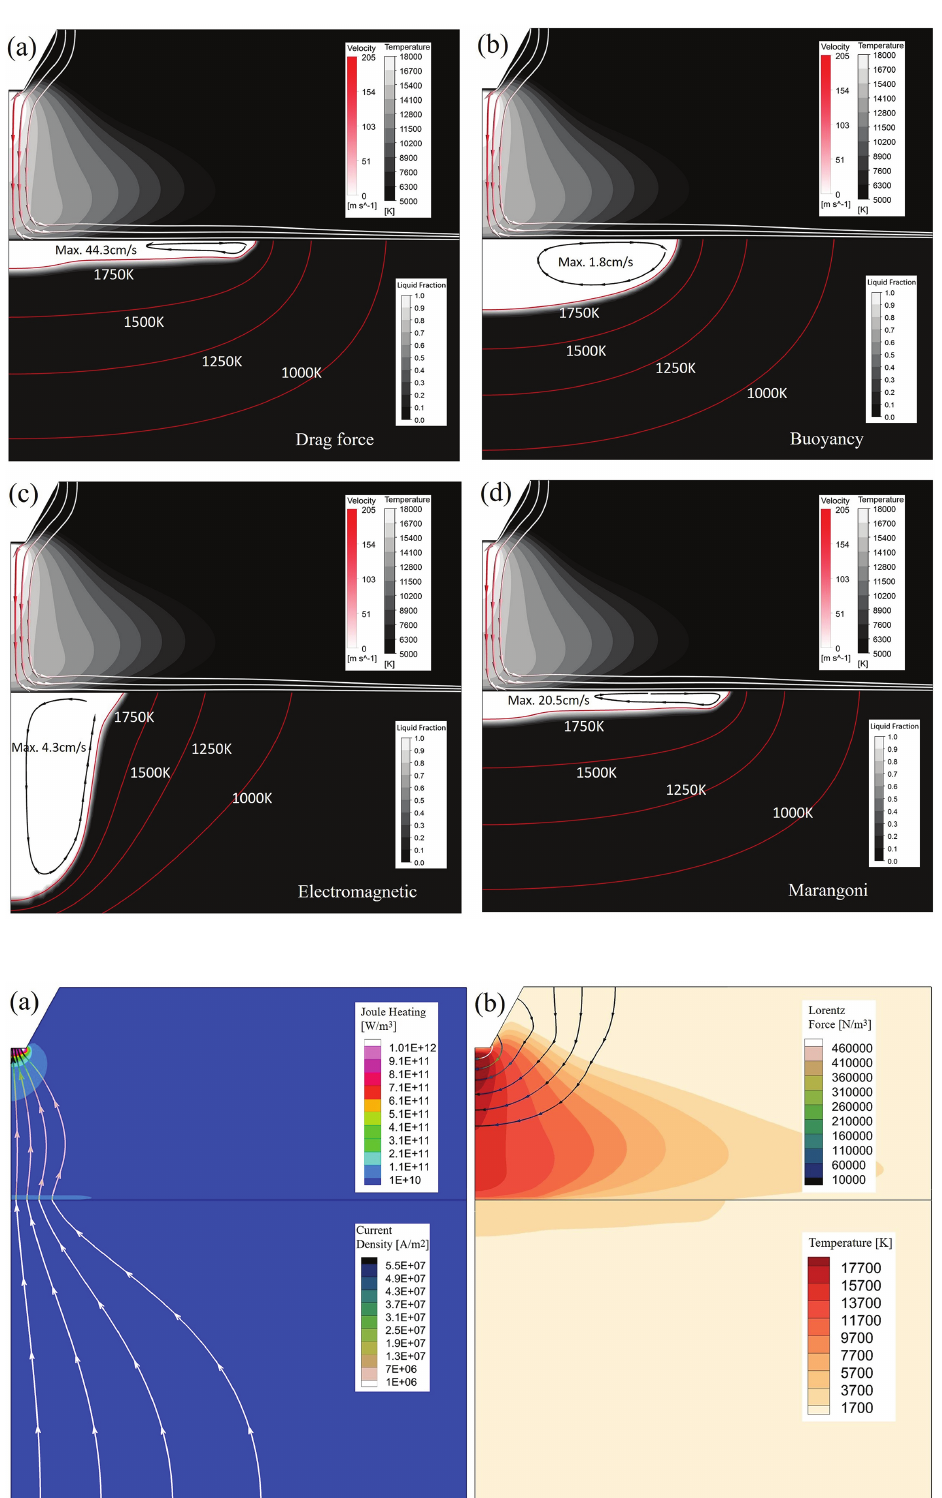
Figure 9 is the temperature field and weld pool shape calculated by the unified model without interface deforma- tion. The temperature field is compared with the result of